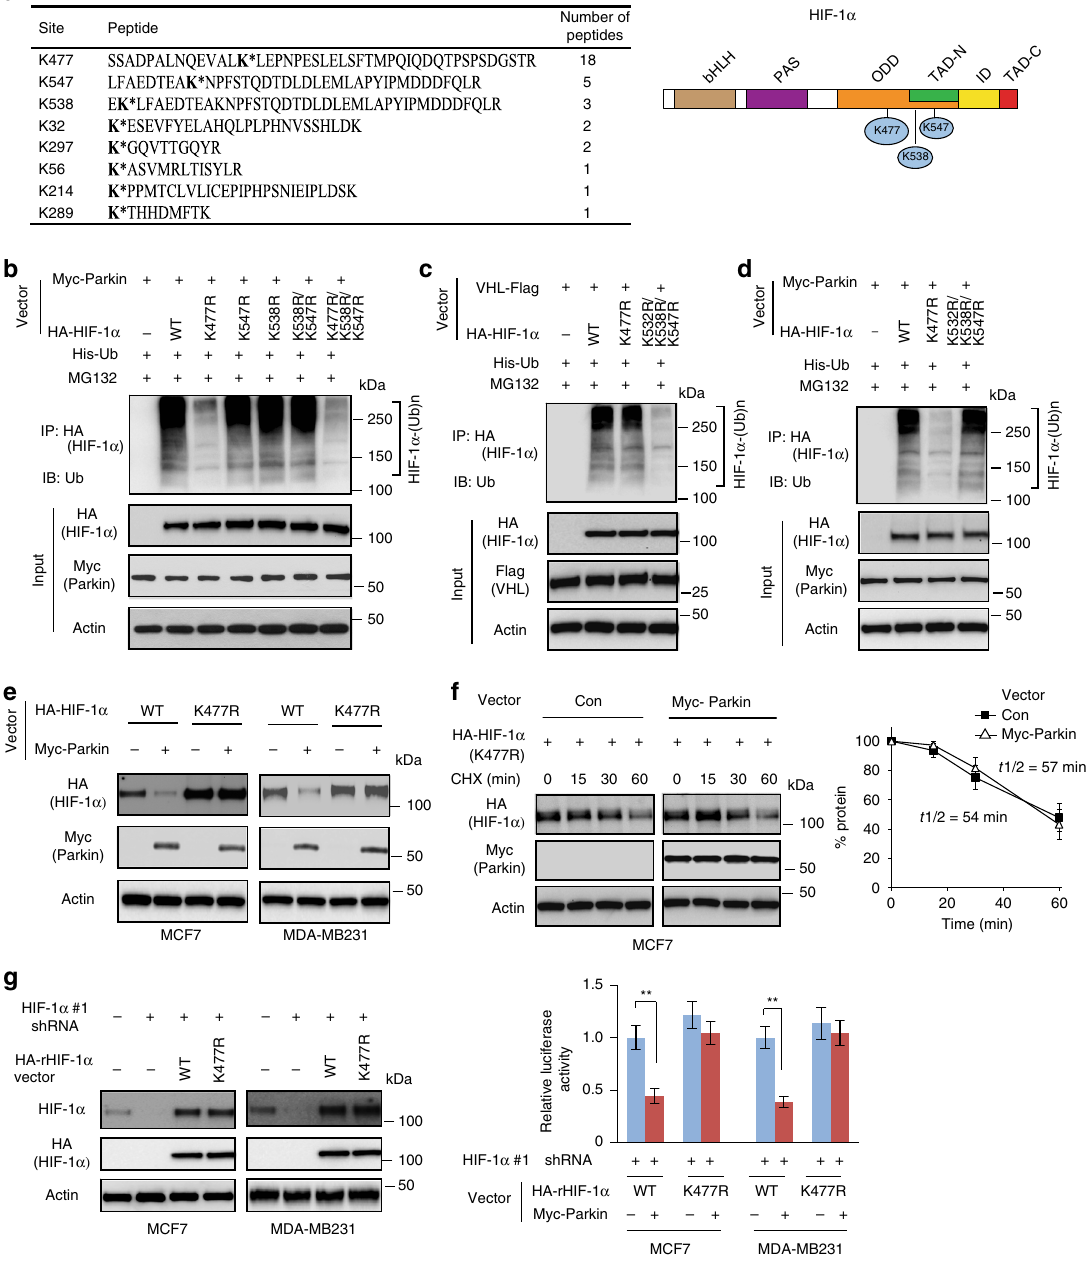
Fig. 5 Ubquitination of HIF-1 α by Parkin at lysine 477. a Left panel: sequences and counts of peptides containing potential ubiquitination sites identi fi ed by LC-MS/MS analysis in MCF7 cells with ectopic expression of HA-HIF-1 α , Myc-Parkin and His-Ub. *: represents potential lysine ubiquitination site. Right panel: Positions of the top three potential ubiquitination sites in HIF-1 α , including K477, K538 and K547. b K477 mutation (K477R) largely abolished ubiquitination of HIF-1 α by Parkin. MCF7 cells were transfected with indicated vectors for in vivo ubiquitination assays. c VHL ef fi ciently ubiquitinated K477R but not K532R/K538R/K547R mutant HA-HIF-1 α in MCF7 cells analyzed by in vivo ubiquitination assays. d Parkin ef fi ciently ubiquitinated K532R/ K538R/K547R but not K477R mutant HA-HIF-1 α in MCF7 cells analyzed by in vivo ubiquitination assays. e K477R mutation largely abolished the negative regulation of HA-HIF-1 α protein by Myc-Parkin in MCF7 and MDA-MB231 cells. Cells were transduced with vectors expressing WT or K477R HA-HIF-1 α together with Myc-Parkin vectors. f Myc-Parkin expression did not affect the K477R HA-HIF-1 α protein half-life. MCF7 cells with ectopic Myc-Parkin expression and control cells were transfected with K477R HA-HIF-1 α . The data present mean ± S.D. ( n = 3). g K477R mutation largely abolished the inhibitory effect of Parkin on HIF-1 α luciferase reporter activities in cells. MCF7 and MDA-MB231 cells were transduced with HIF-1 α -shRNA #1 to knock down endogenous HIF-1 α , and then transduced with vectors expressing WT or K477R HA-HIF-1 α resistant to HIF-1 α -shRNA (HA-rHIF-1 α ) (left panels). Cells were then transfected with the HIF-1 α luciferase reporter vector together with Myc-Parkin vectors for luciferase reporter assays (right panel). The data present mean ± S.D. ( n = 6). **: P < 0.001; two-tailed Student's t